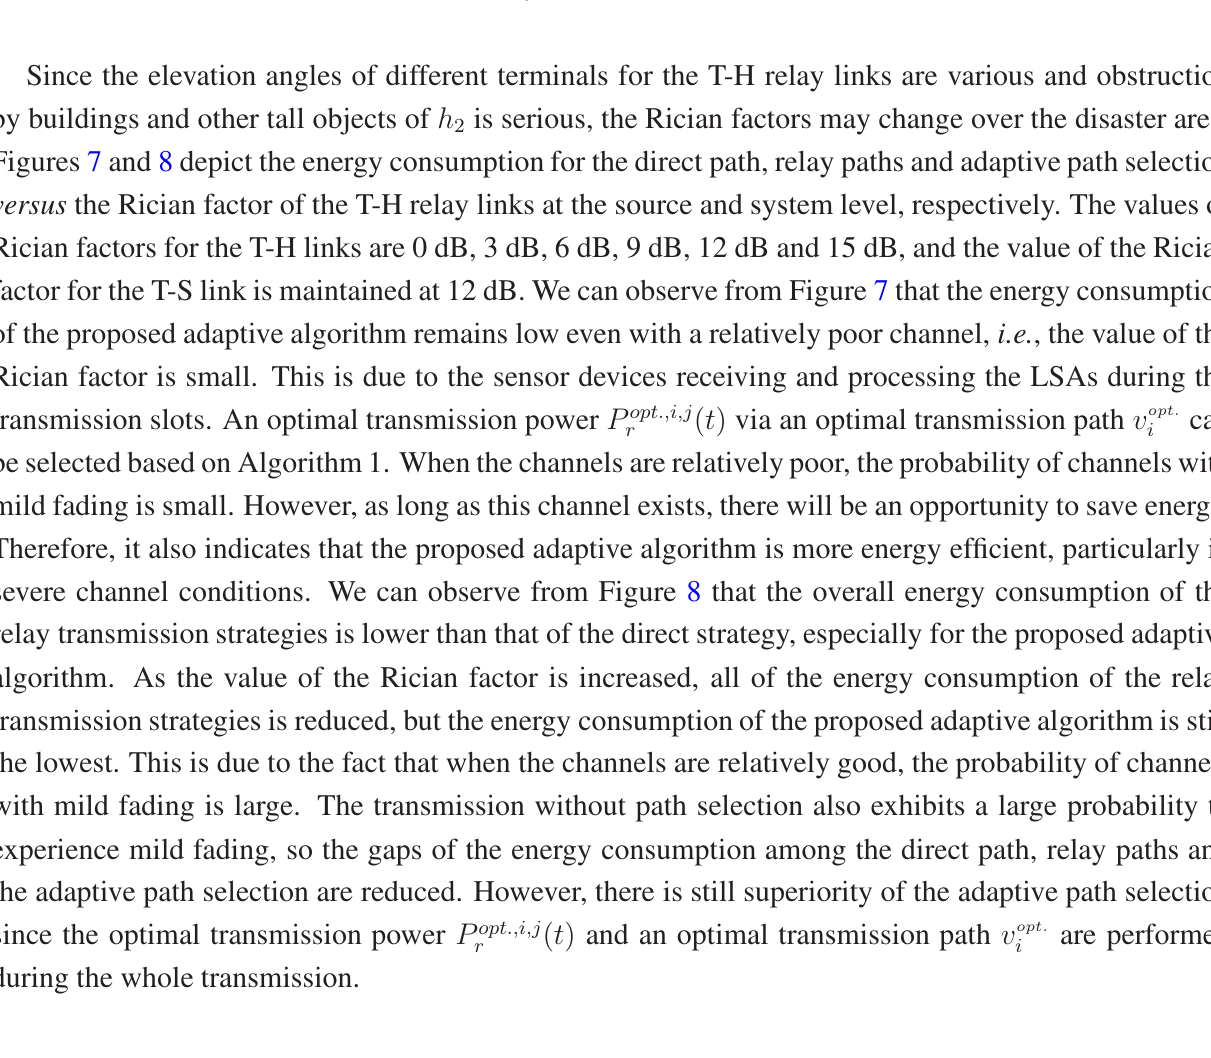
Figure 6. Energy consumption for the direct path, relay paths and adaptive path selection versus the number of terminals at the system